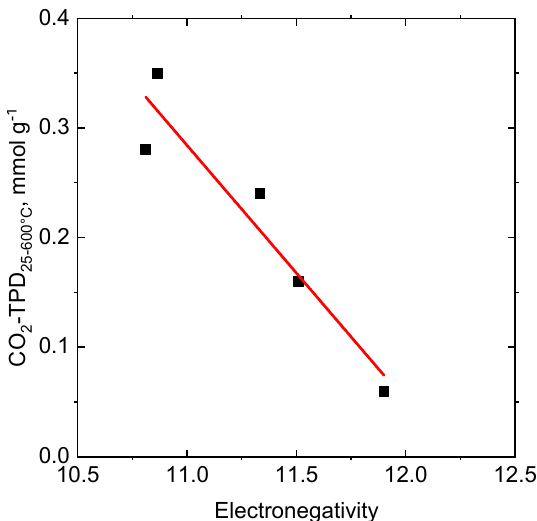
Figure 7. Dependence of basicity (determined in temperature range 25–650 °C) on electronegativity of oxides (Co 3 O 4 , Al 2 O 3 , Mn 2 O 3 , K 2 O, and CeO 2 ) hypothetically present in the catalysts.